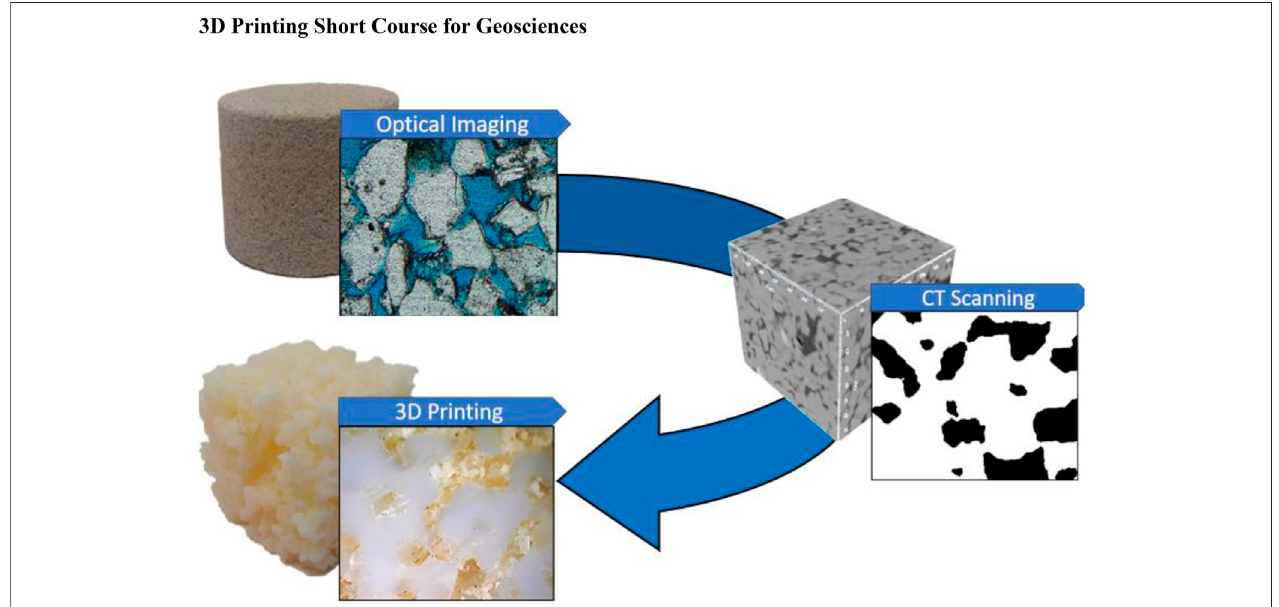
FIGURE 10 | Work fl ow for generation of 3D-printed samples from digital models. Source data are either optical or CT images of natural rocks (e.g., Berea sandstone). Images aresegmented intopores and grains; thegrain volume istransferredto3D printingsoftware asaCADmodel. Selected3Dprintercreates atangible model layer-by-layer (polymer in this example). Pore space is fi lled with support material (soft polymer) that is removed by post-processing.